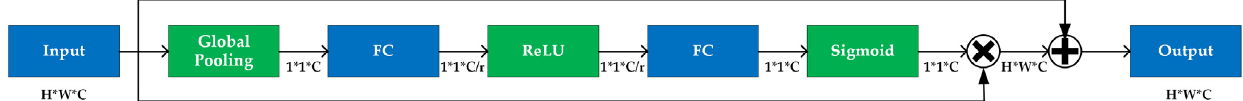
Figure 4. The structure of channel-wise attention module.